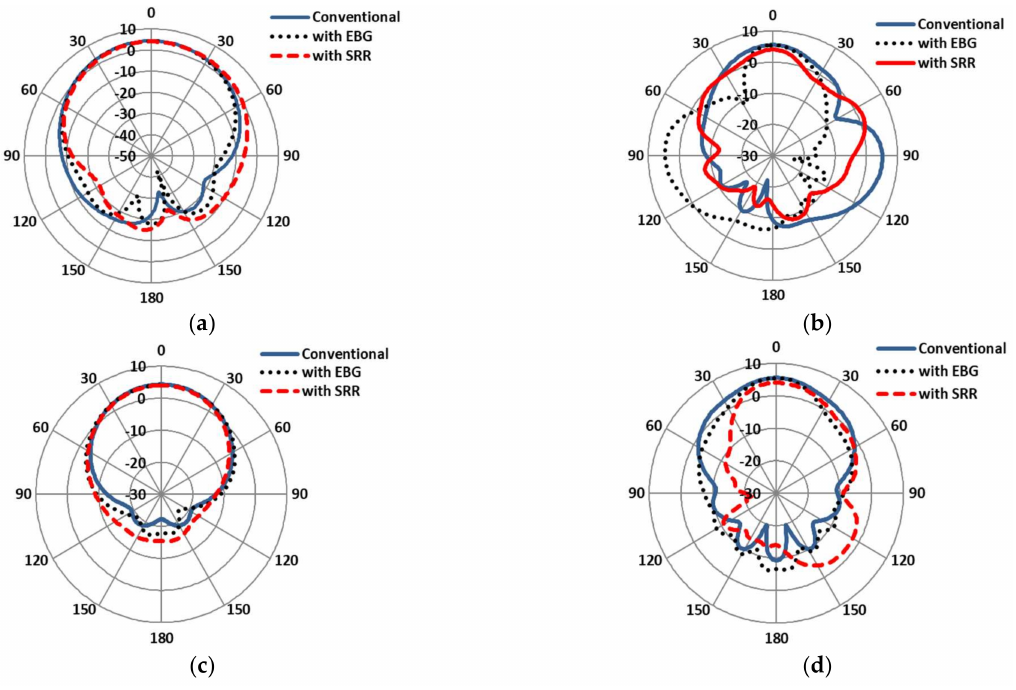
Figure 16. Gain patterns comparisons of conventional antenna under bent condition (free space).